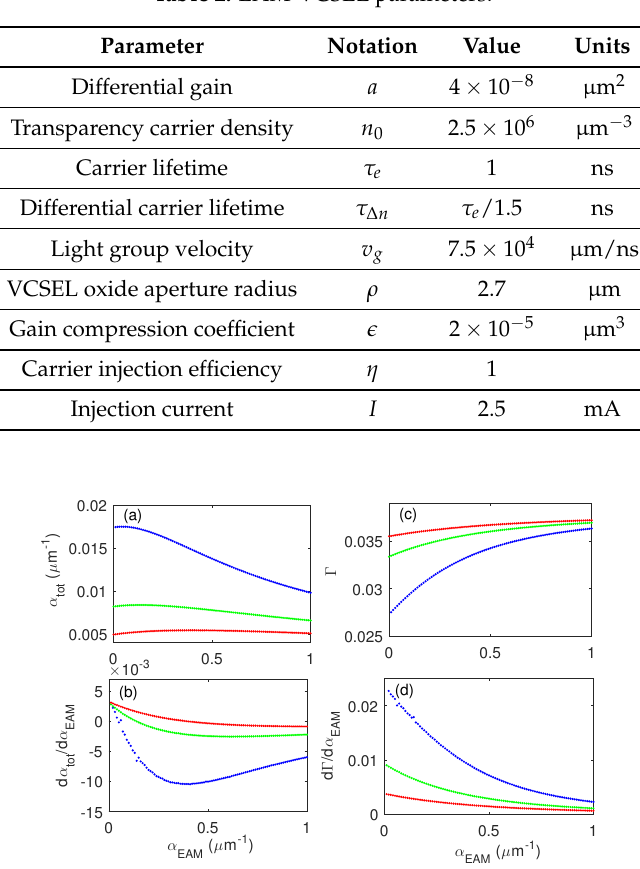
Table 2. EAM-VCSEL parameters.